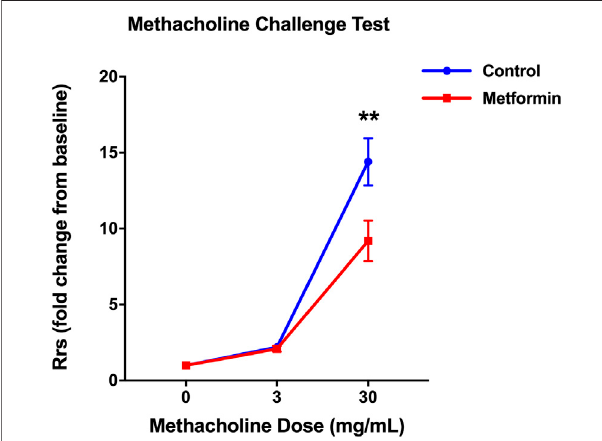
FIGURE 4 | Metformin treatment decreased total resistance of the respiratory system (Rrs) in response to methacholine in diet-induced obese mice. The Rrs values were normalized to baseline (no signi fi cant difference between groups at baseline). Data was presented as mean ± standard error of the mean. ** denotes p < 0.01 between two groups.